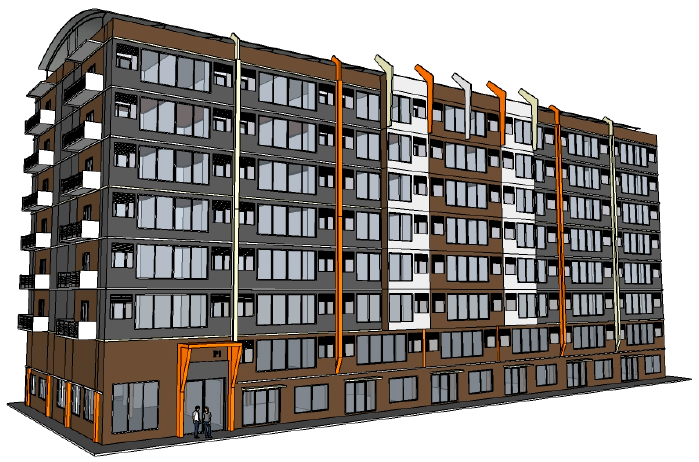
Figure 1. SketchUp diagram of an eight-story residential building analyzed as a case study.